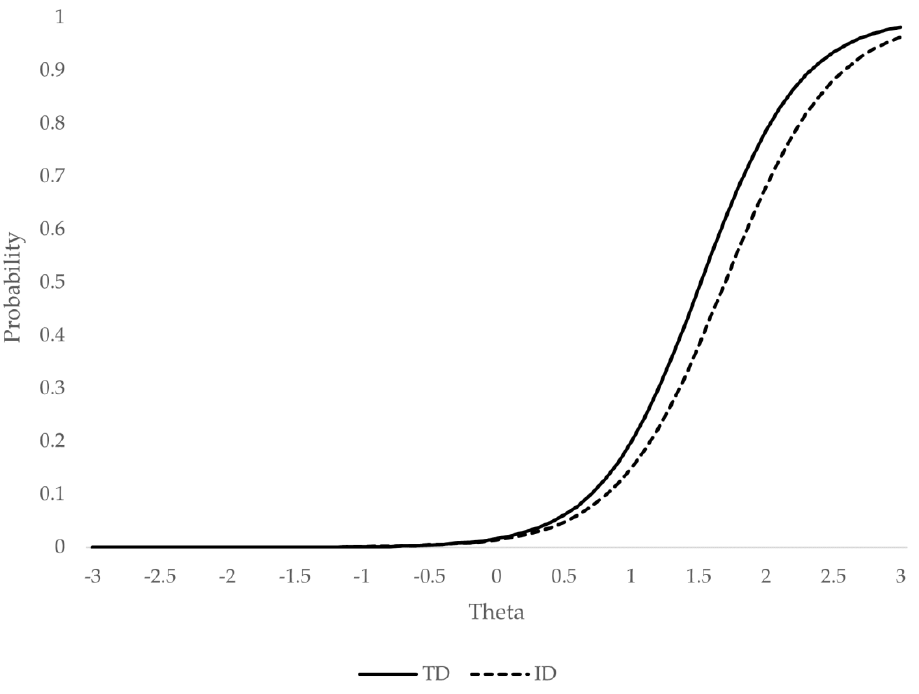
Figure 3. Probability of endorsing the category “often” or higher for the symptom “argues with adults”. Note: TD = typical development; ID = intellectual disability.